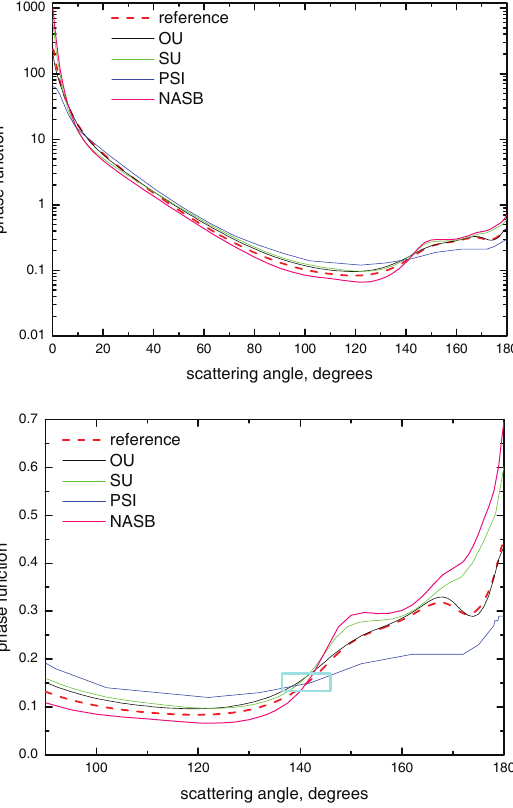
Fig. 17. The comparison of phase functions used in retrievals with the reference phase function (λ = 550nm ) for ORAC, SU, PSI, and NASB retrievals. The square shows the region, where the retrievals are least sensitive to the selection of aerosol